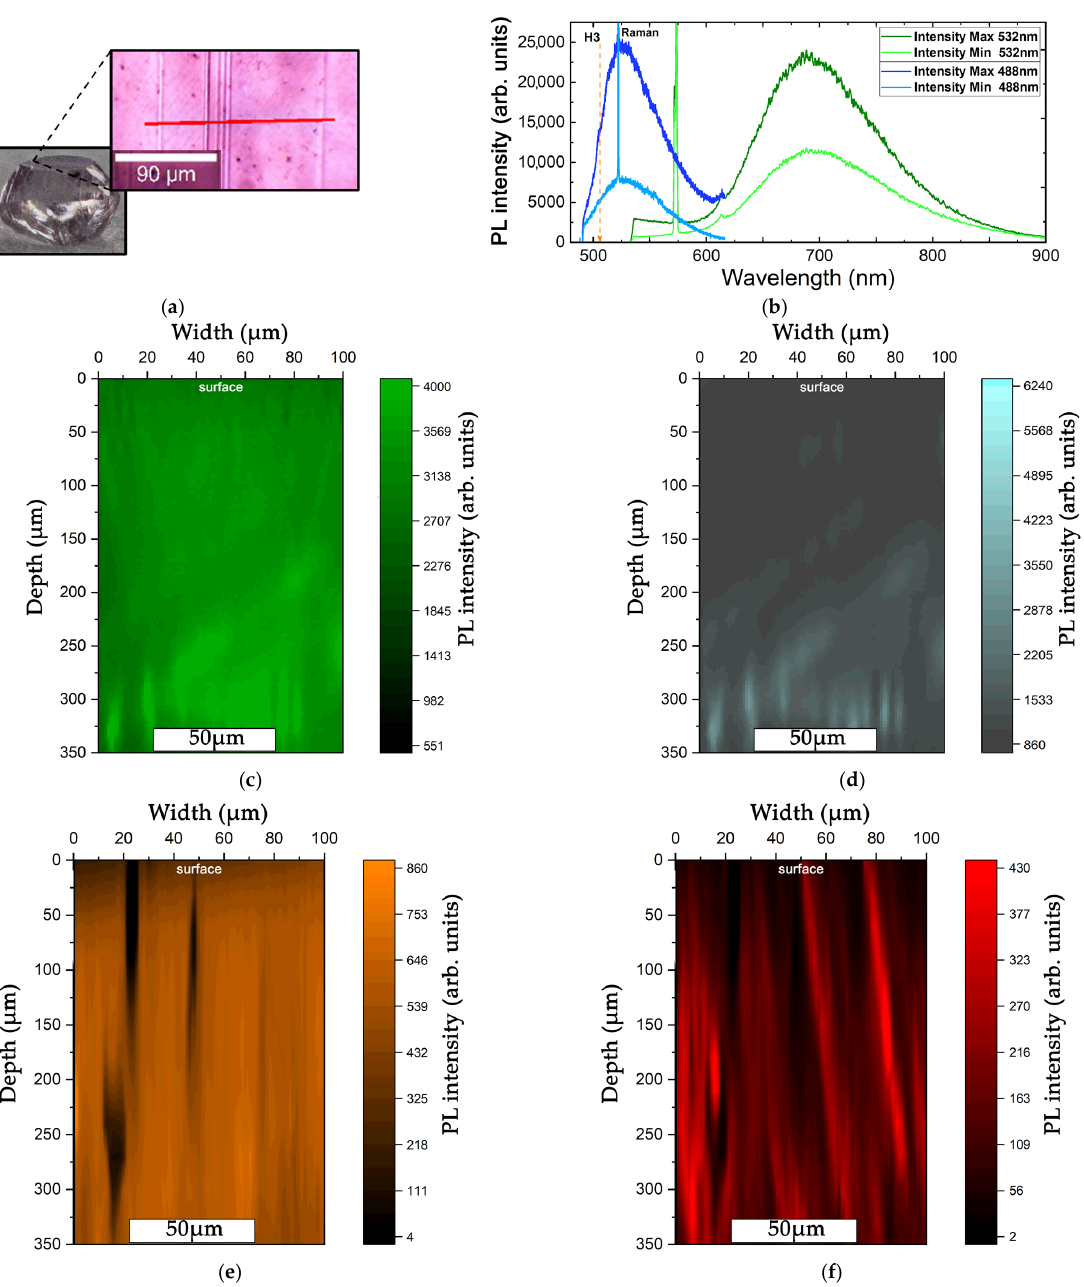
Figure 6. ( a ) Optical image of the diamond and (inset) its magnified view in the near-surface region with microscale plastic deformation zones; ( b ) Raman and PL spectra of the plastic deformation zones (Intensity Max) and reference spot outside zones (Intensity Min), excited at 488- and 532-nm wavelengths; ( c ) Raman map of the diamond at 522-nm wavelength (excitation wavelength—488 nm); ( d ) PL map of the diamond at 550-nm wavelength, representing the spatial abundance of H3/H4 centers (excitation wavelength—488 nm); ( e ) Raman map of the diamond at 573-nm wavelength (excitation wavelength—532 nm); ( f ) PL map of the diamond at 700-nm wavelength, representing dislocation-related centers (excitation wavelength—532 nm).